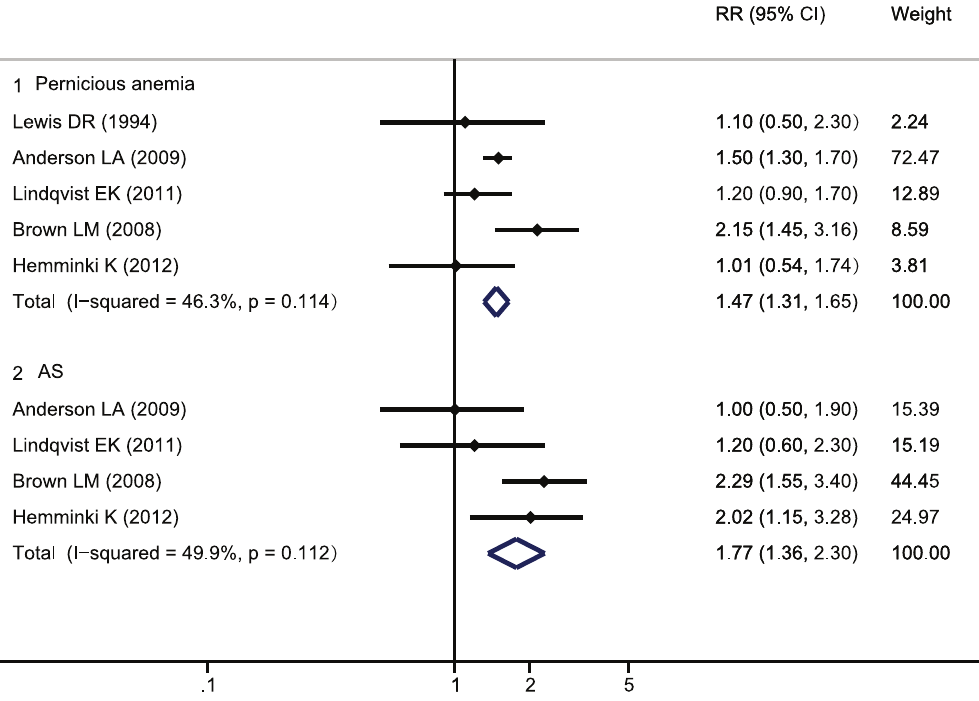
Figure 4. Forest plot of studies on multiple myeloma development risk in pernicious anemia and AS.